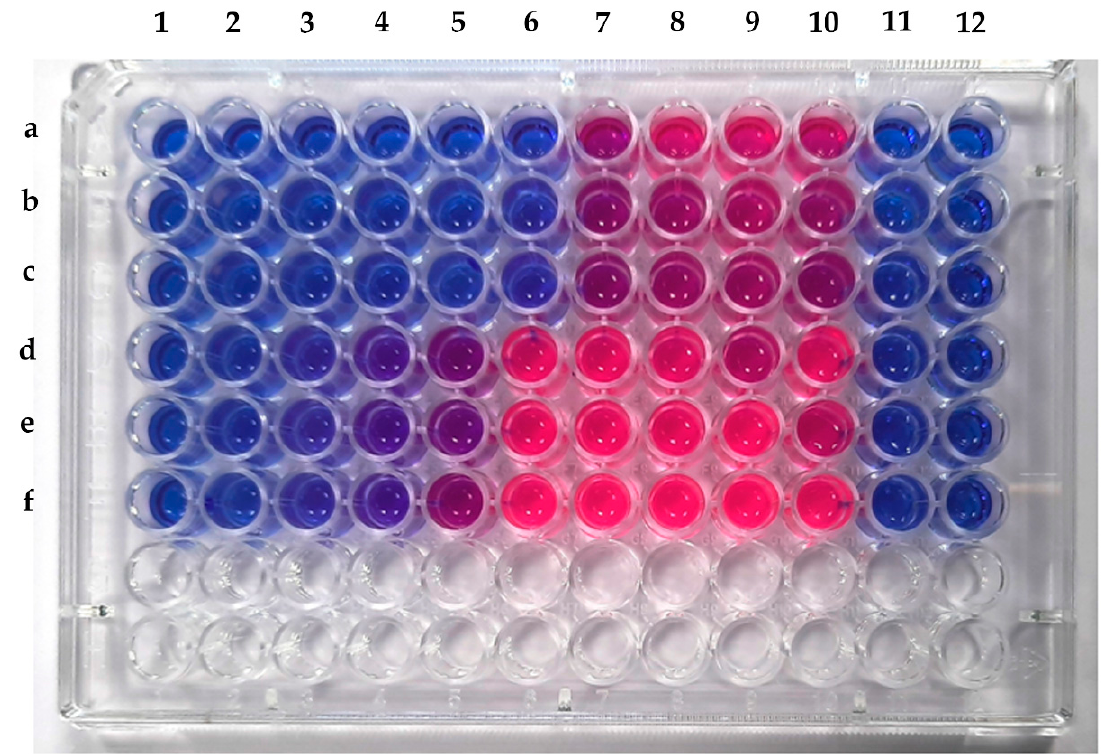
Figure 8. Microtiter plate showing MIC of crude extract of F . tardicrescens NFCCI 5201 against Staph- ylococcus aureus MLS16 MTCC 2940 (Rows a–c) and Micrococcus luteus MTCC 2470 (Rows